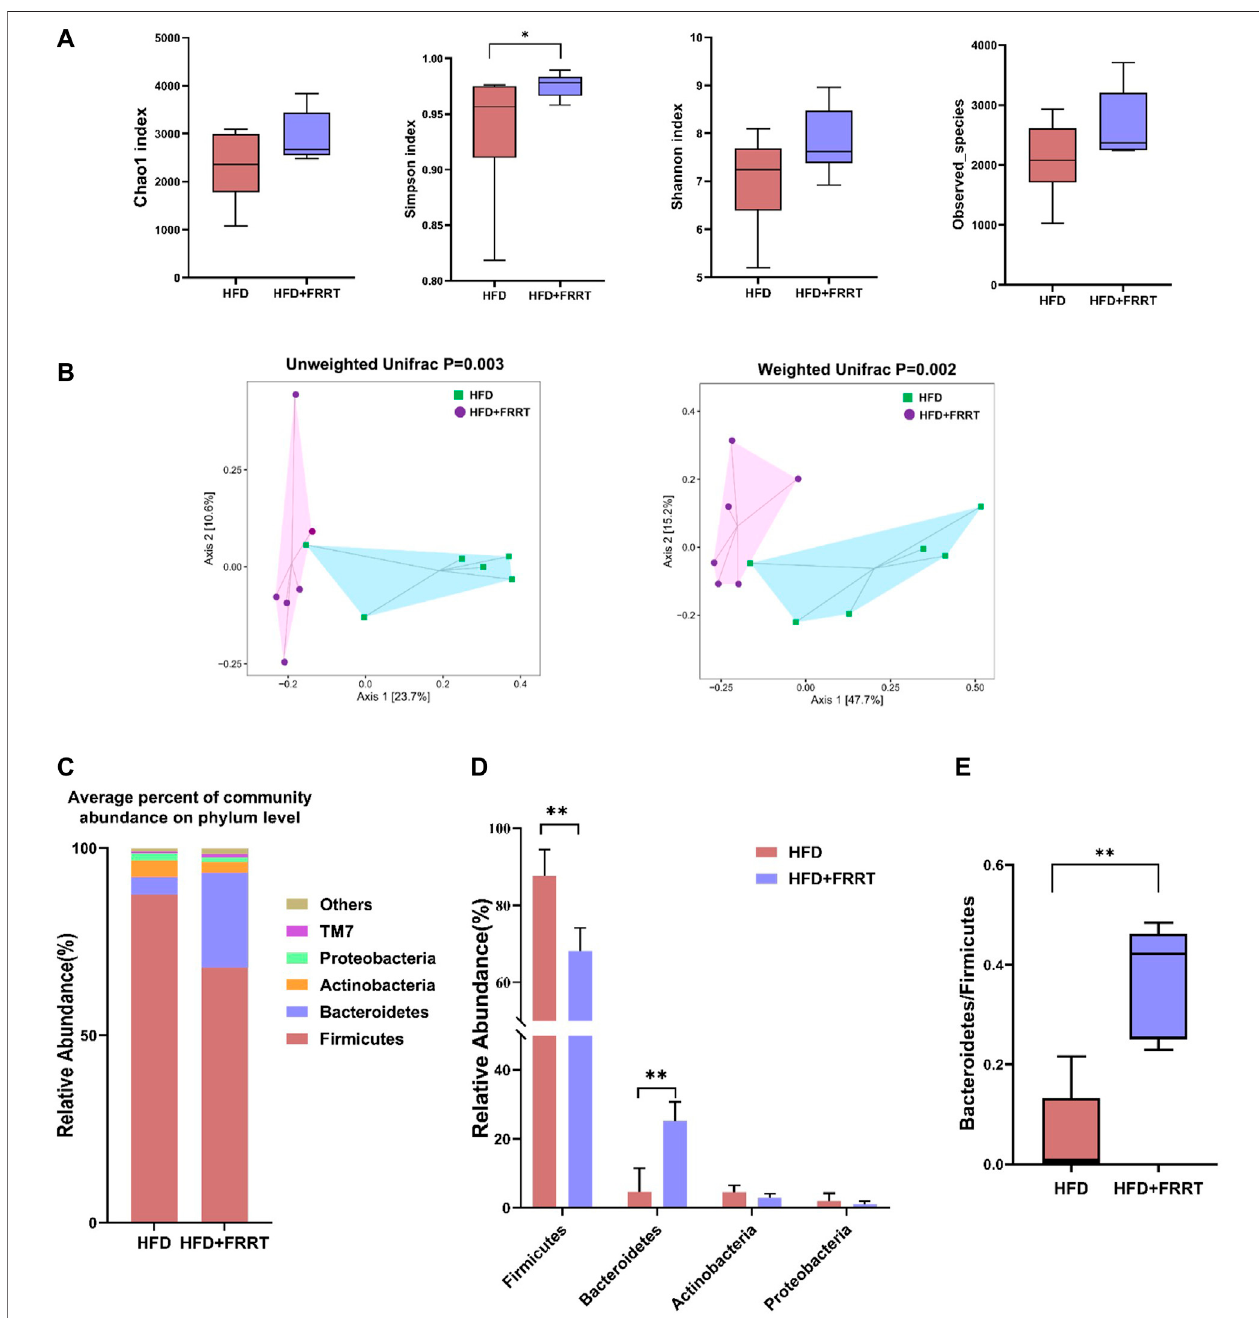
FIGURE 3 | The alteration of the gut microbiome in HFD rats. (A) The a -diversity indexes of Chao1, Shannon, Simpson, and observed-species of gut microbiota betweenHFDandHFD+FRRTrats. (B) UnweightedbasedPCoAandweightedUniFracbasedPCoAbetweengutbacterialcommunitiesofHFDandHFD+FRRTrats. p values were determined by the ADONIS test. Differential abundances of genera were determined by the Wilcoxon rank-sum test and Mann-Whitney U test. (C) The average percent of community abundance on phylum level in HFD and HFD + FRRT groups. (D) Relative abundance of Firmicutes, Bacteroidetes, Actinobacteria, Proteobacteria, and the Bacteroidetes/Firmicutes abundance ratio (E) in fecal microbiota between HFD and HFD + FRRT. (F) The LEfSe analysis of the gut microbiota differed between HFD and HFD + FRRT groups. (G) The effect of the gut microbiota modi fi cations on predicted functional metabolic pathways obtained from PICRUSt analysis of 16S rDNA sequencing